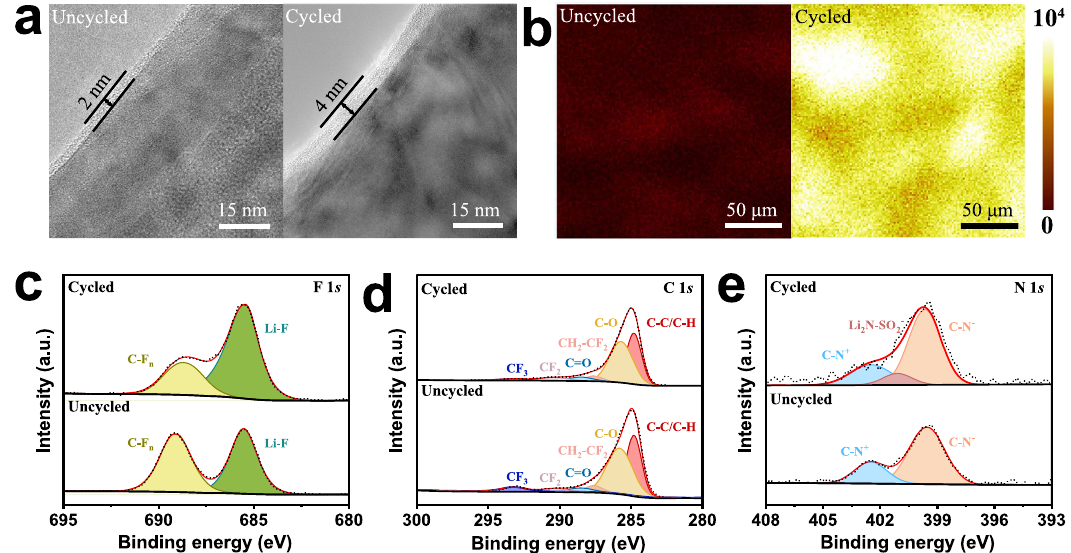
Fig. 5 | Characterizations of cathode interface evolution. a HRTEM images of NCM523 cathode particles before and after 200 cycles. b 2D TOF-SMIS measured LiF images of NCM523 cathode surface before and after 200 cycles. c – e XPS